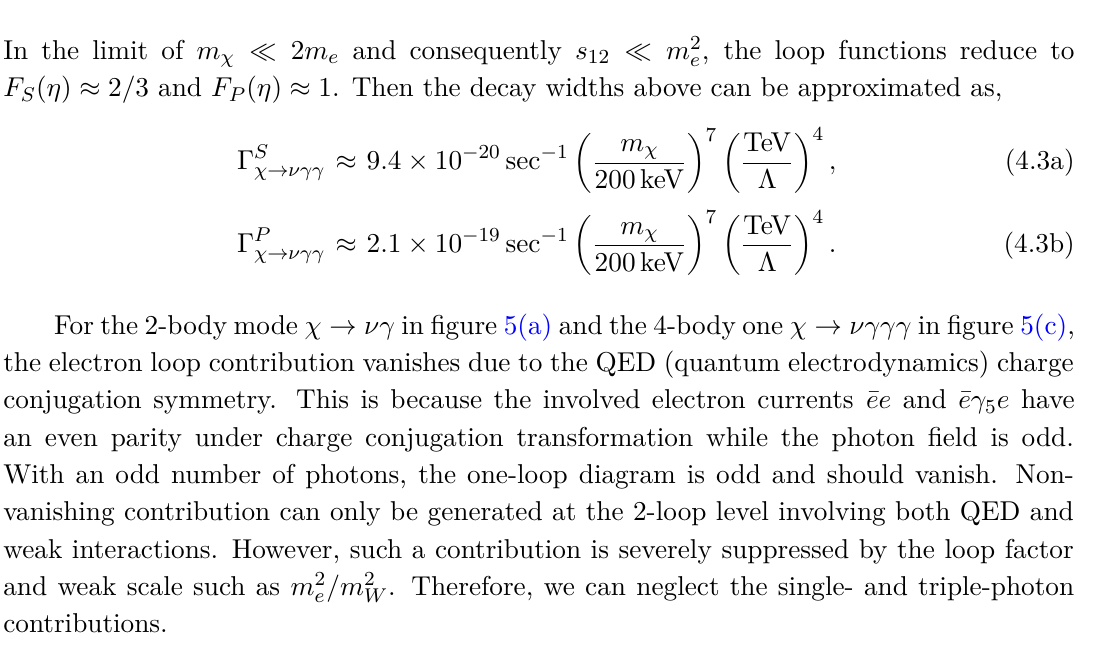
Table 1 . Contributions of the Fermionic DM absorption operators to the visible ( χ → νγ ( s ) ) and invisible ( χ → 3 ν ) decay channels. The one allowed at one-loop level is shown with a checkmark ( X ) or a cross ( × ) if otherwise. For those that allowed at one-loop level but highly suppressed, an exclaimed cross ( × ! ) is